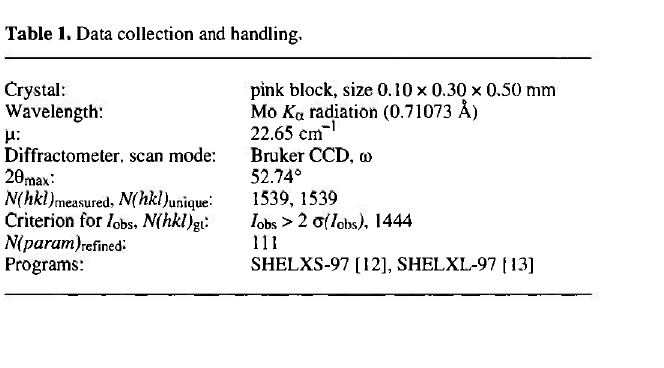
Table 1. Data collection and